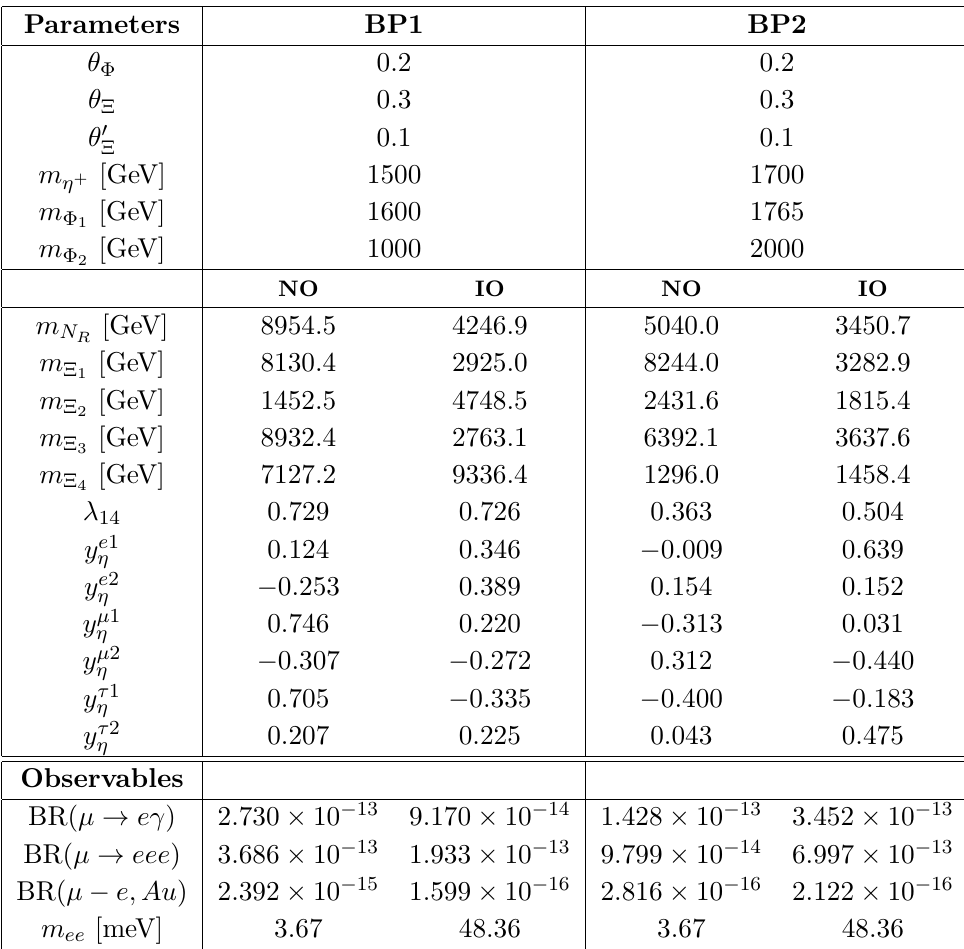
Table 4 . Input parameters, cLFV observables and 0 ν 2 β effective mass for the selected benchmark points BP1 and BP2. They satisfy all the current constraints and accommodate the CDF anomaly while offering detectable signals in future cLFV and 0 ν 2 β decay experiments.